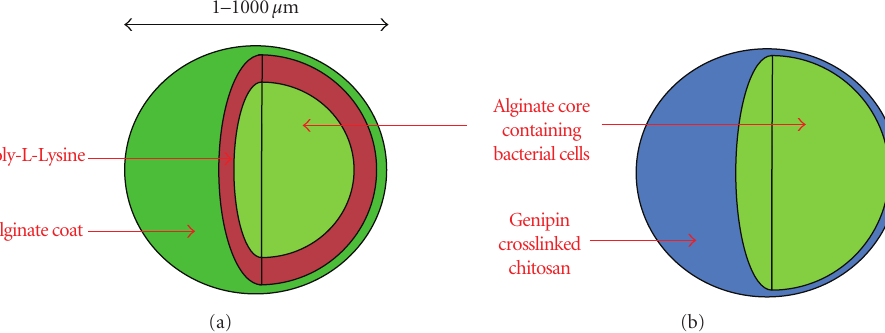
Figure 3: The concept of microcapsules for probiotic delivery. (a) Alginate-Poly-L-Lysine (APA) and (b) Genipin Crosslinked Alginate Chitosan (GCAC)